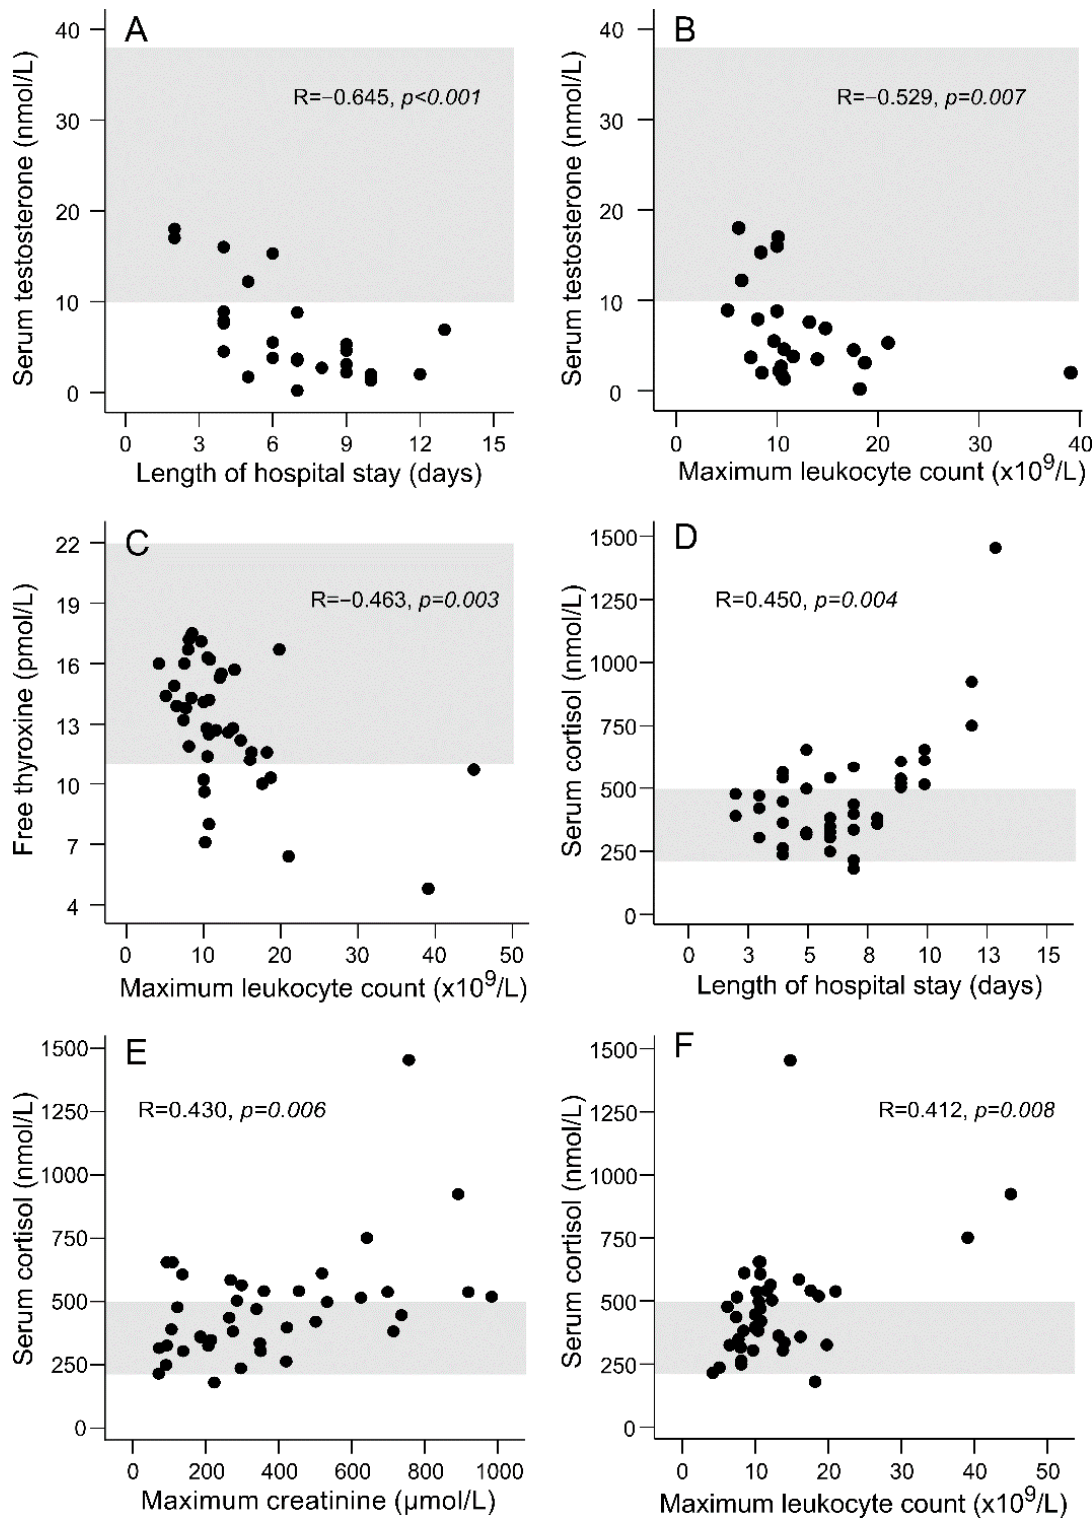
Figure 2. Scatter plots illustrating the correlations between serum testosterone level and the length of hospital stay ( A ) and maximum leukocyte count ( B ), between free thyroxine level and the maximum leukocyte count ( C ), between serum cortisol level and length of hospital stay ( D ), maximum creatinine level ( E ) and maximum leukocyte count ( F ) in patients with acute Puumala hantavirus infection. The reference range for each hormone is marked with shading.